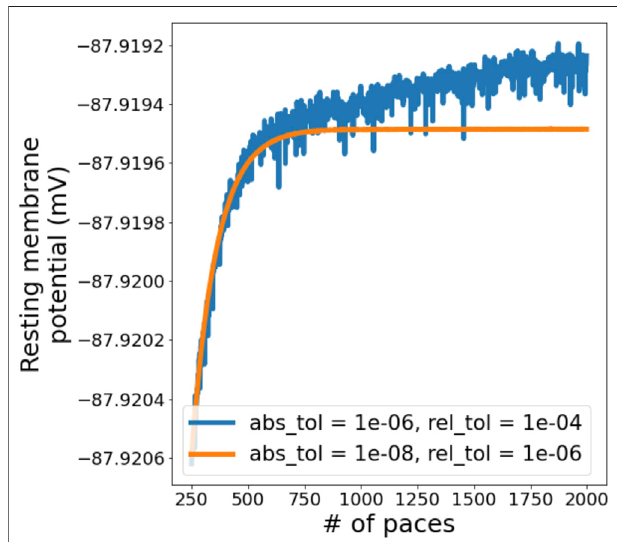
FIGURE 2 | Evolution of resting membrane potential (RMP) in a simulation with the derivative- V m ORd-CiPA model, starting from the published initial conditions. 2000 paces were simulated, we are showing paces 250 onwards to examine the behaviour close to periodic steady state. A slight drift is observed when using a coarse solver tolerance, but this disappears when tolerances are tightened.